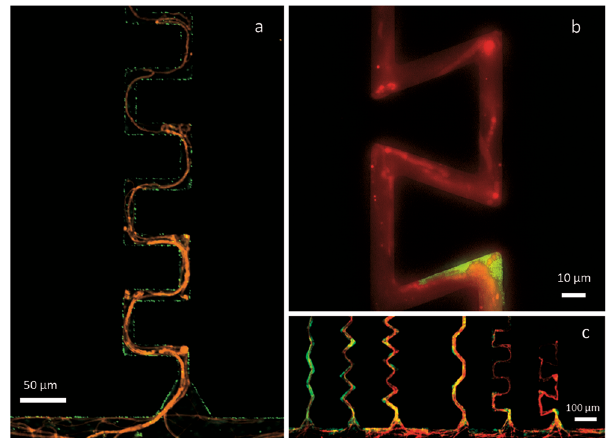
Fig. 1 Epi fl uorescence images of the bacterial strain P. putida mt-2 (green) grown together with the fungal strain C. cinerea AmutBmut PMA412 (red) in amended M9 liquid medium inside the PDMS chip on day 2 after inoculation. a 90°-angled channel with repeated turn order. b 109°-angled channel with repeated turn order where fungal hyphae block the channel and do not allow bacteria to advance further. c All studied channel types (from left to right: 45°, 90°, and 109°, with alternated turning order, and 45°, 90°, and 109°, with repeated turning order) at 4x magni fi